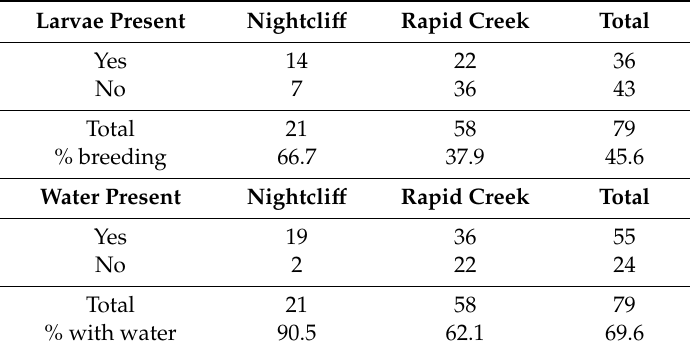
Table 1. Side entry pit sumps sampled during the 2005 dry season for the presence of water and mosquito larvae in Nightcli ff and Rapid Creek,